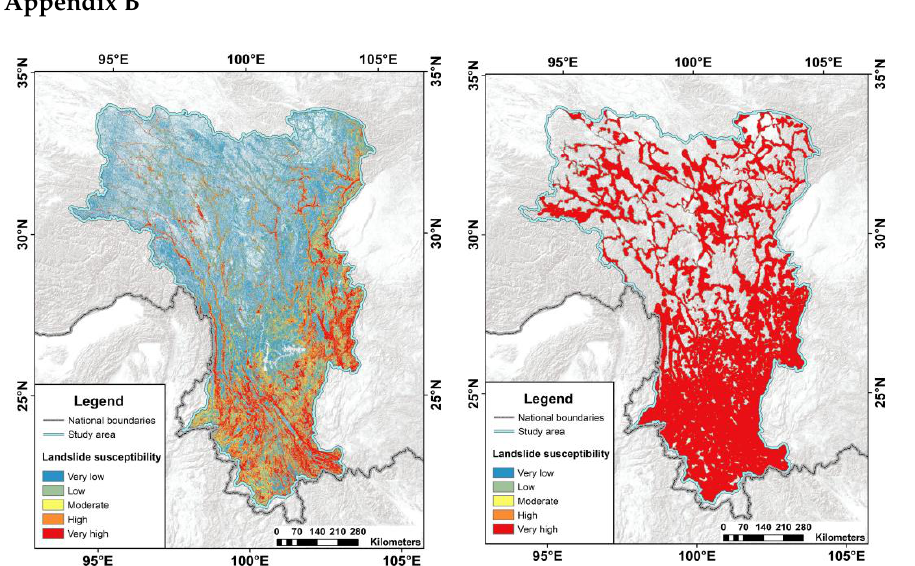
Figure A1. Landslide susceptibility mapping using CART and SVM model, respectively. ( Left ): LS result using CART model. ( Right ): LS result using CART model.